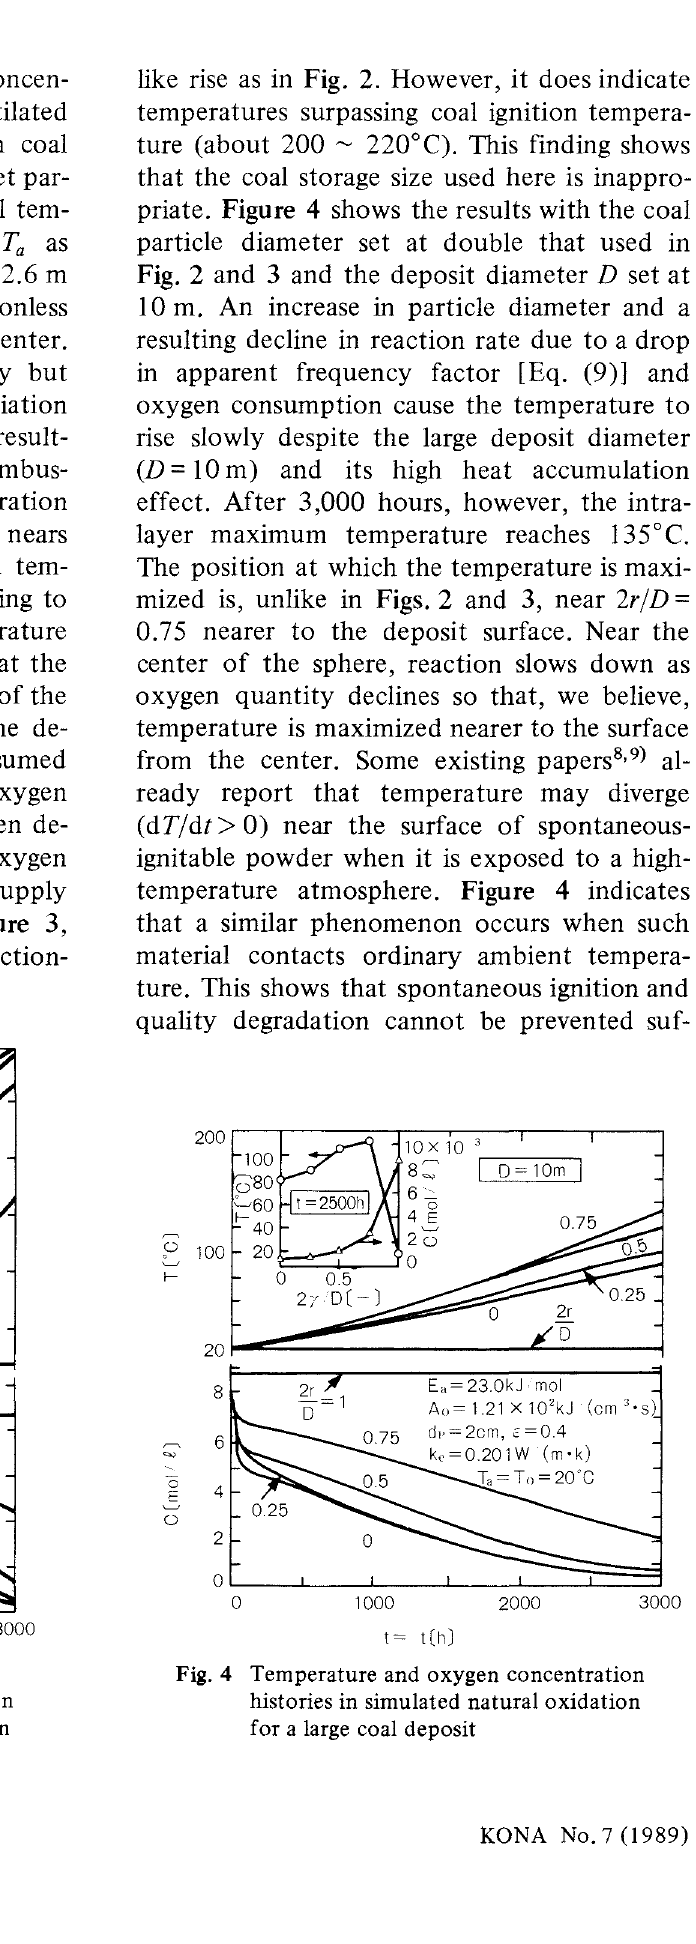
Fig. 3 Temperature and oxygen concentration histories in simulated natural oxidation